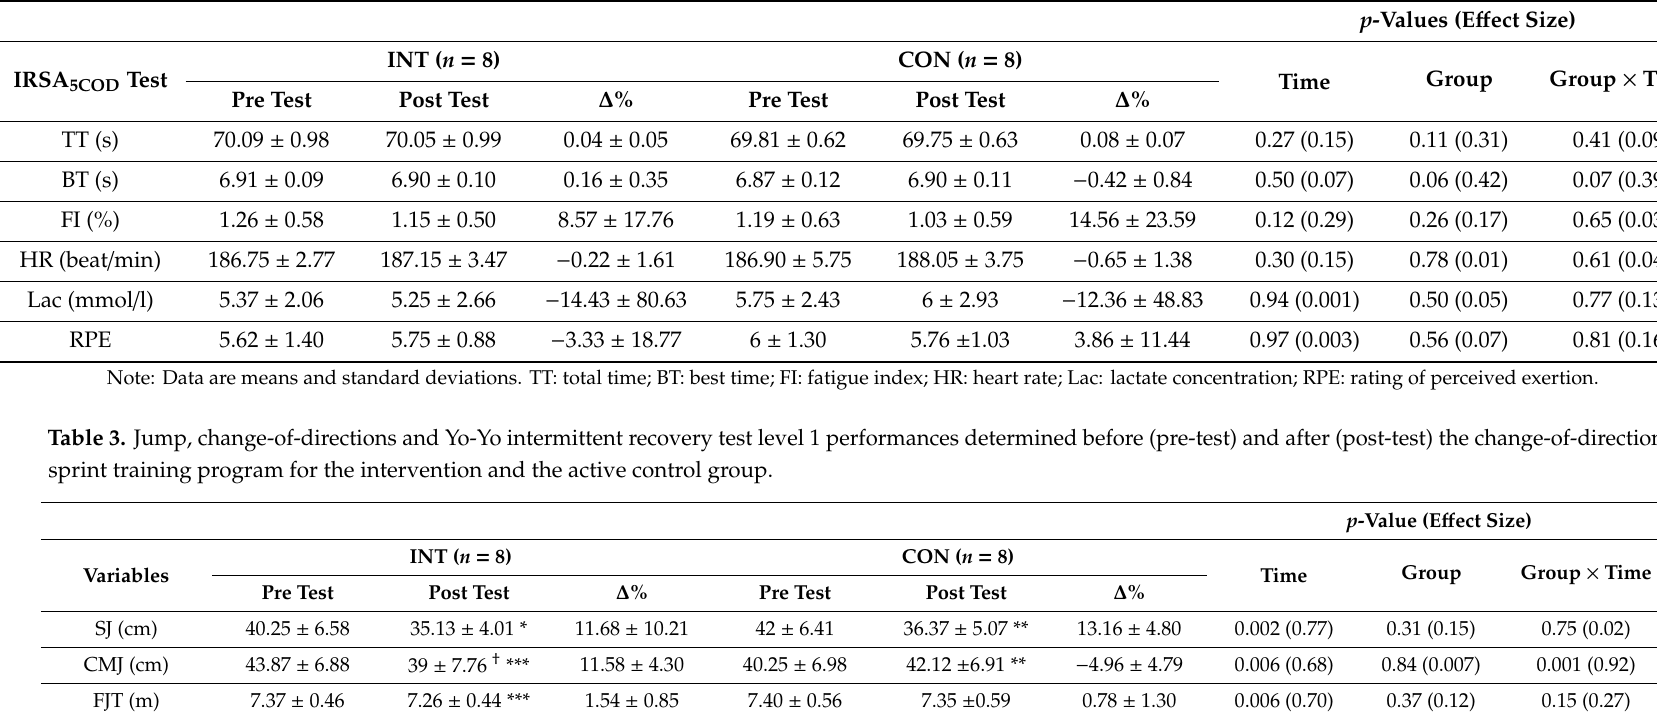
Table 2. Intensive repeated sprint ability test performances and physiological parameters determined before (pre-test) and after (post-test) the change-of-direction sprint training program for the intervention and the active control group.